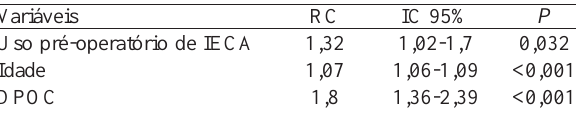
Tabela 4. Análise multivariada de preditores de fibrilação atrial